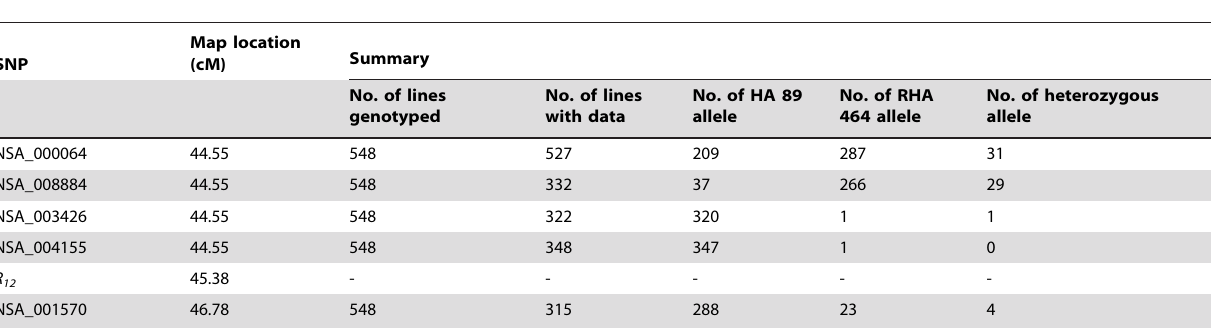
Table 3. Validation of SNP markers linked to the rust gene R 12 in a diverse sunflower germplasm pool.